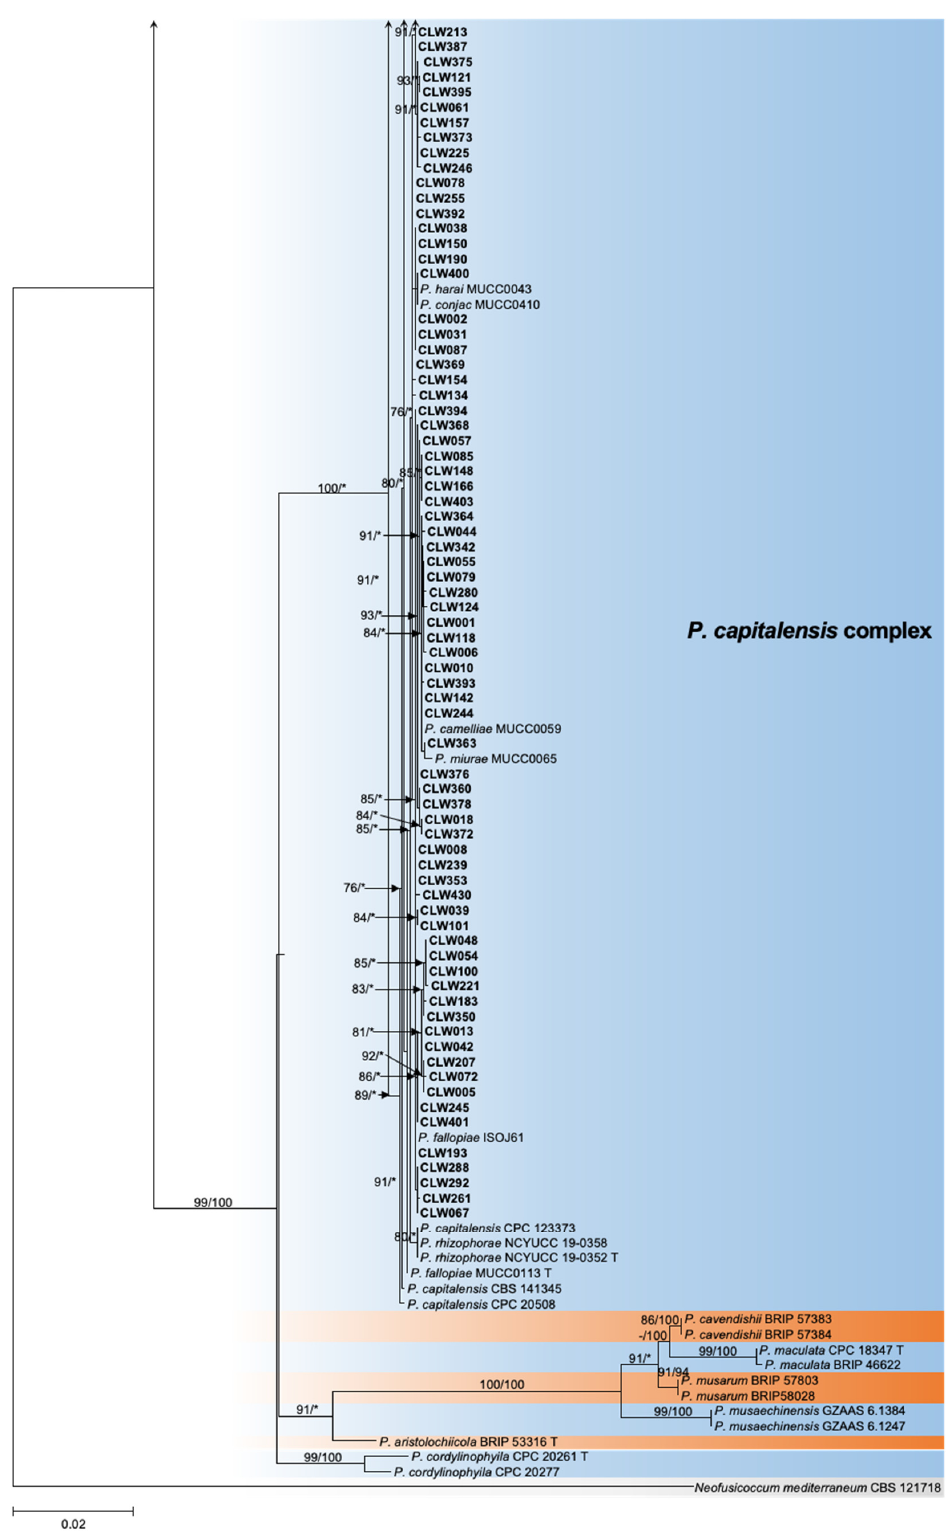
Figure 2. Maximum likelihood phylogeny of 194 Phyllostica isolates related to citrus. The tree was built using concatenated sequences of ITS, actA , tef1 , gapdh , LSU , and rpb2 . Isolates sequenced in this study are labeled in bold font. Bootstrap support values ≥ 60% for ML and MP are shown on branches as ML/MP, whereas bootstrap values < 60% or absent are marked with ‘-’, or ‘*’, respectively. Ex-type isolates are marked with ‘T’. The trees were rooted with Neofusicoccum mediterraneum (CBS